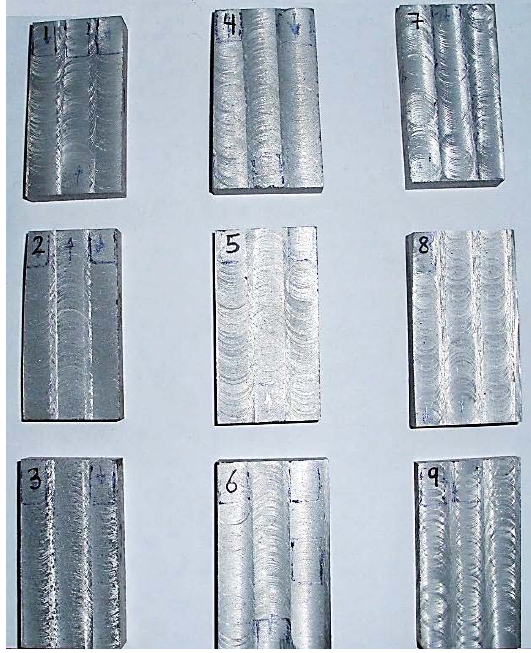
Fig. 5. Cutting procedure using CNC vertical milling machine system for Al-alloy (4032) samples.